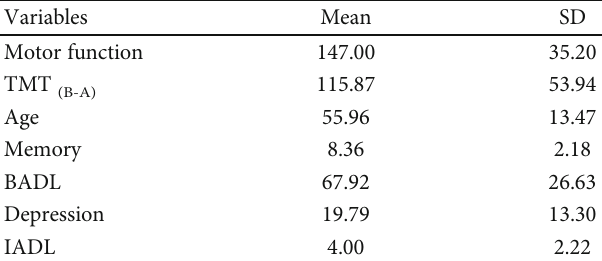
Table 2: Mean and standard deviation of variables ( N = 82 ).